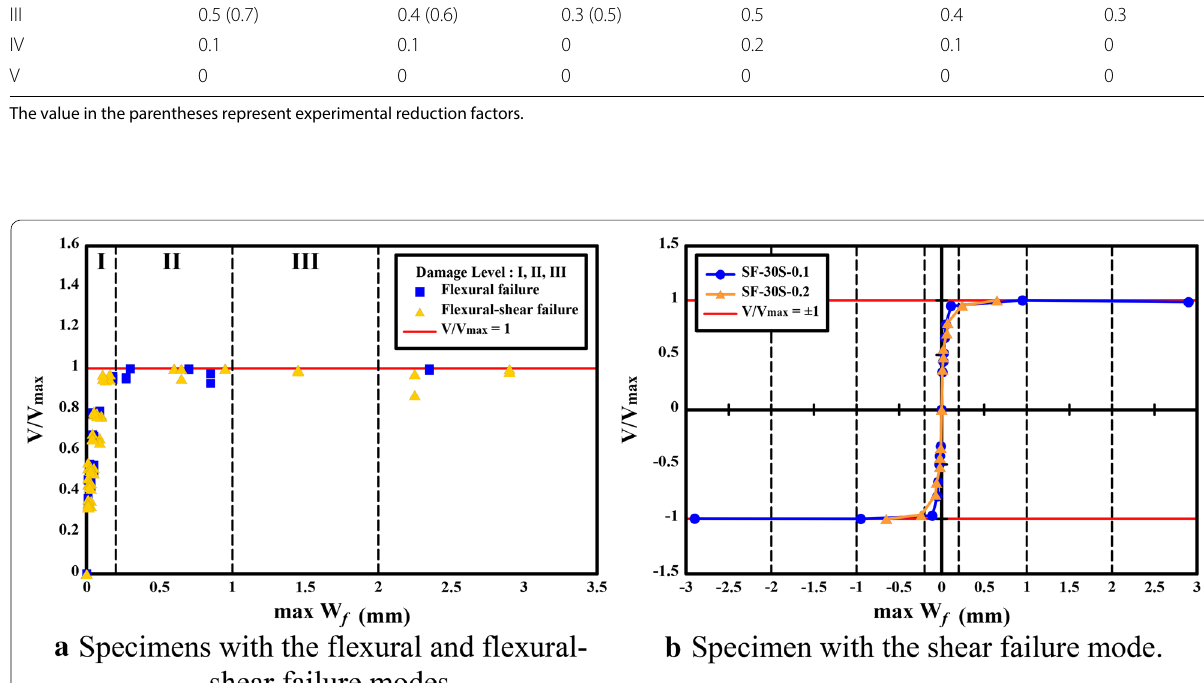
Fig. 15 Relationship between the reduction factor of strength and maximum residual flexural crack width.